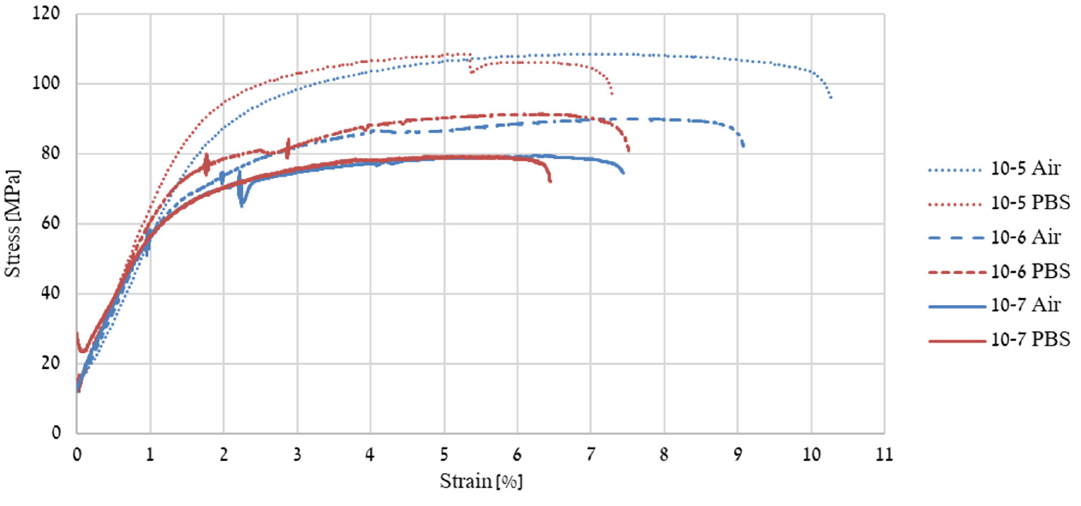
Figure 4. Typical stress–strain curves of Zn-2%Fe-0.6%Ca alloy in air and PBS solution for strain rates between 10 − 5 to 10 − 7 S − 1.